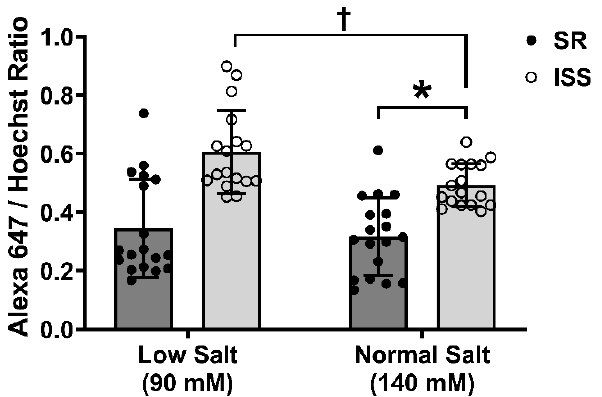
Figure 7. Plasma membrane Aminopeptidase N (APN) expression in SR and ISS cells under low salt treatment. In-Cell immunofluorescence staining in 96 well plates using an extracellular epitope specific antibody to APN shows that ISS cells have a higher plasma membrane APN expression than SR cells (Normal salt: ISS 0.49 ± 0.02 vs. SR 0.32 ± 0.03, * p < 0.01, n = 18/group, Two-way ANOVA, Tukey’s test). ISS uRPTCs have a further increase in APN expression when cultured under low salt concentration vs. the same cells cultured under normal salt concentration (ISS low salt 0.61 ± 0.03 vs. ISS normal salt 0.49 ± 0.02 † p < 0.05, n = 18/group, Two-way ANOVA, Holm-Sidak post hoc test). ISS = inverse salt-sensitive; SR = salt-resistant.